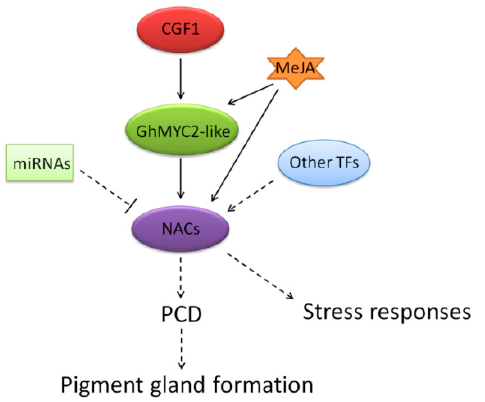
Figure 12. Putative MYC-NAC regulatory network in pigment gland formation.